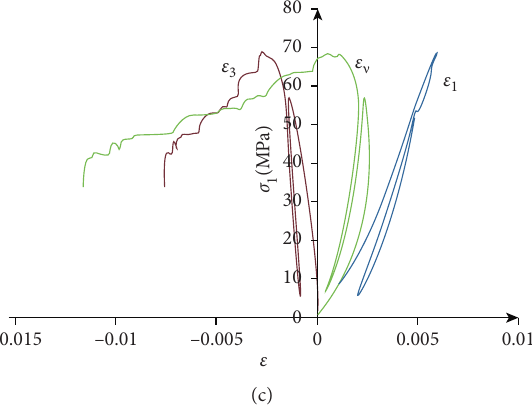
Figure 2: Stress-strain curves of the sandstone specimens: (a) US1; (b) US2; (c)